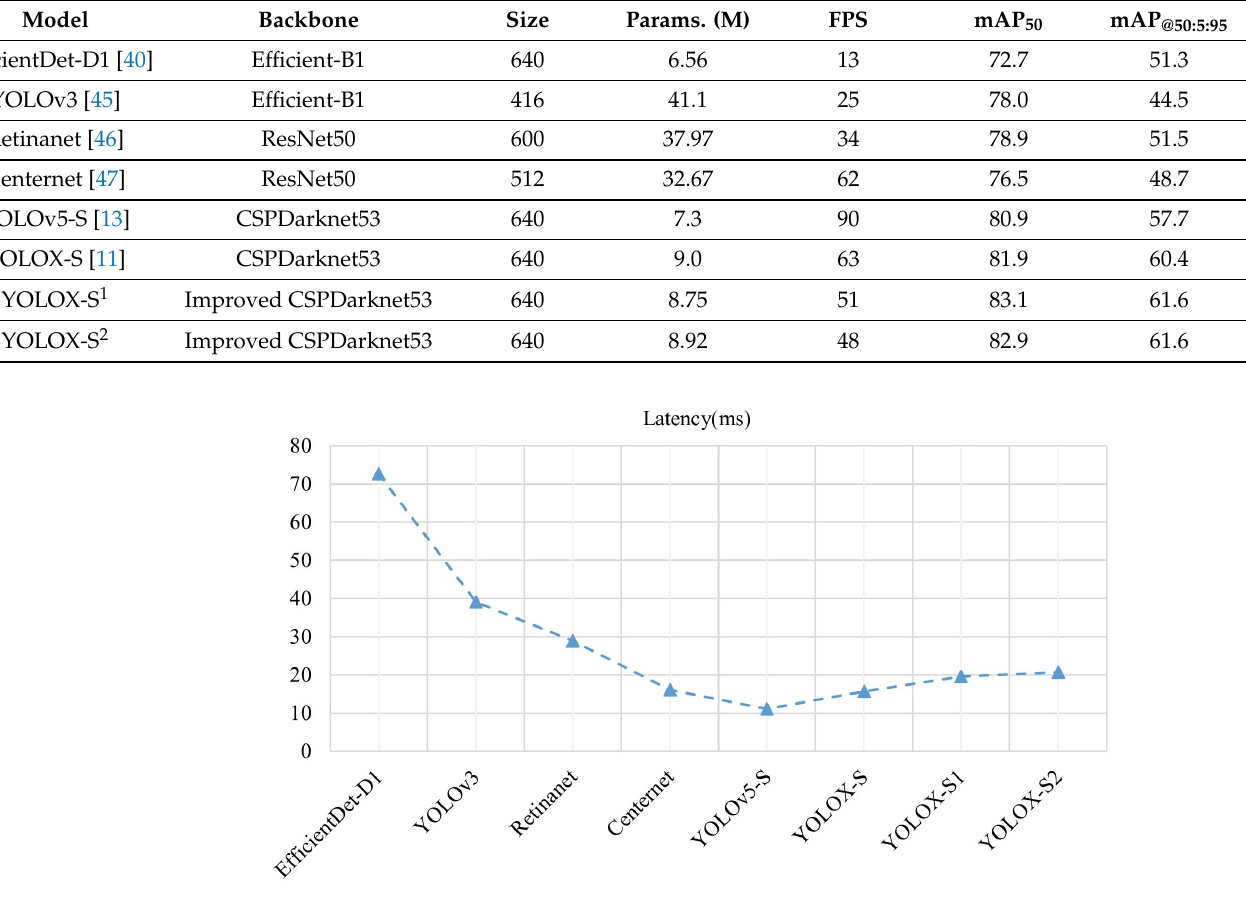
Figure 10. Speed comparison of each algorithm on the PASCAL VOC 2007 test